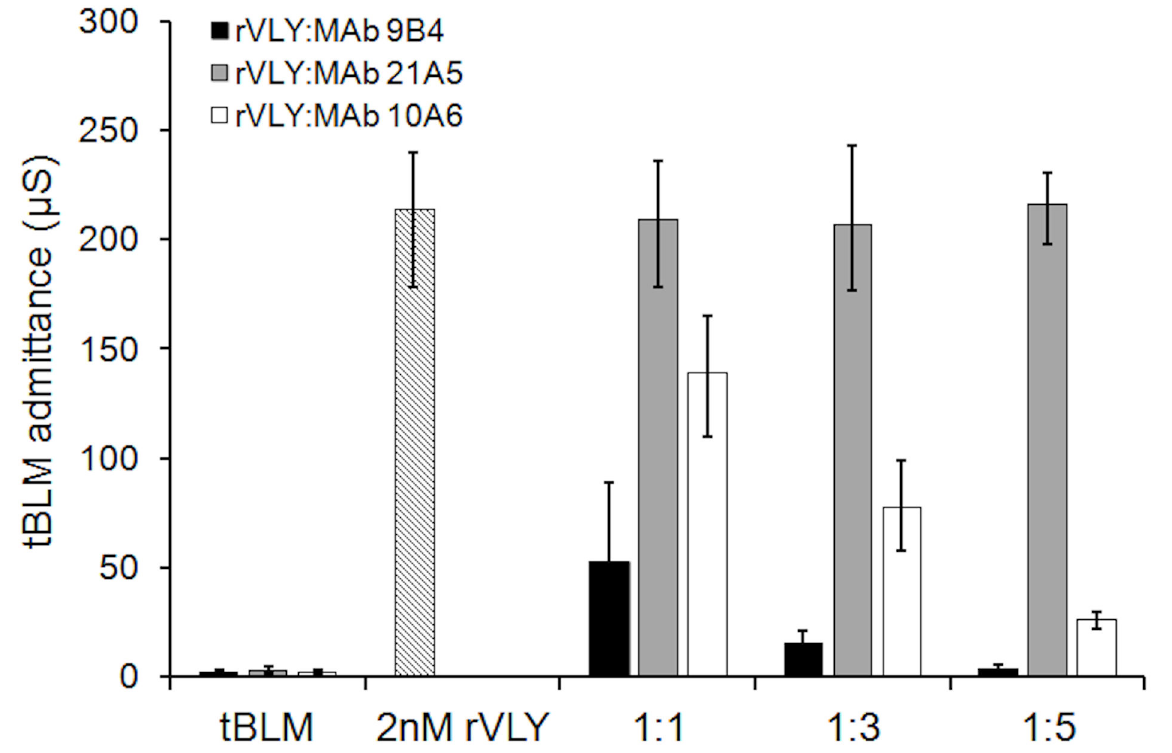
Figure 4. rVLY-induced admittance change of DOPC/CHOL 40% tBLMs after 30 min preincubation with different MAbs: neutralizing MAb 9B4 (black bars), moderate neutralizing MAb 10A6 (white bars) and non-neutralizing MAb 21A5 (grey bars). Exposure of the tBLMs to rVLY time 30 min. rVLY/MAb molar ratios indicated below the abscissa. doi: